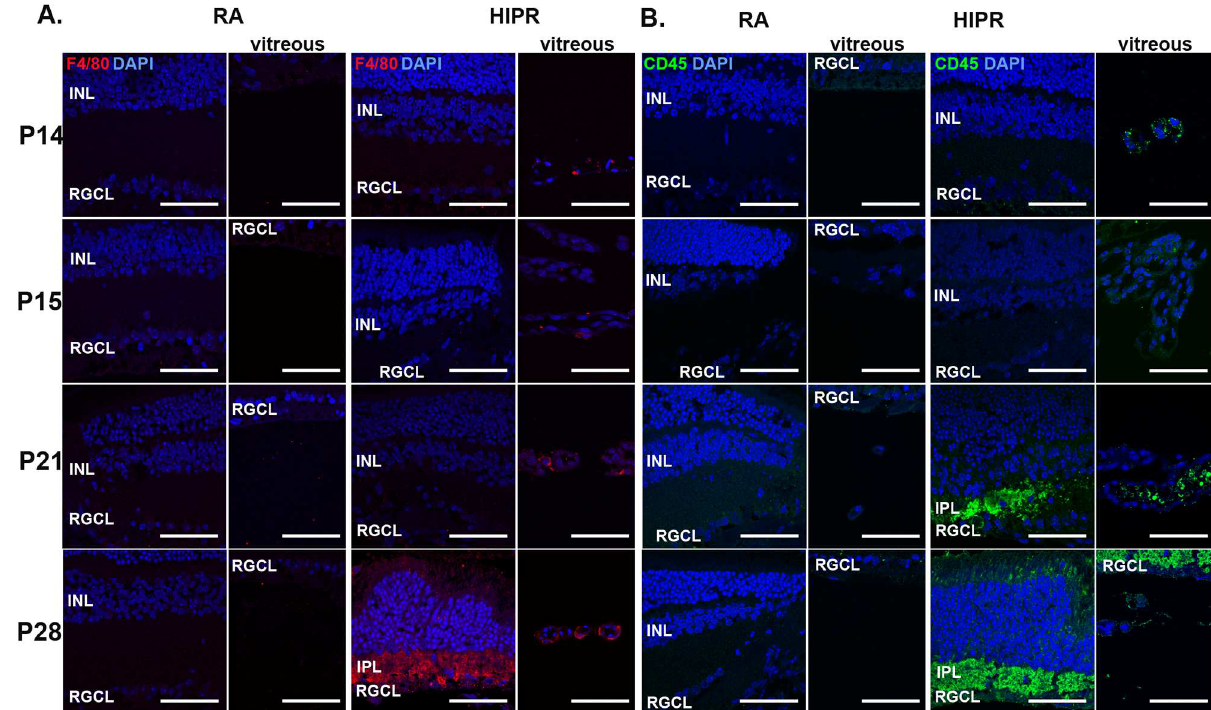
Fig 8. White blood cells present in the inner plexiform layer in hyperoxia-induced proliferative retinopathy. (A) Retinalcross sections were immunostained with (A) F4/80 (red) or (B) CD45 (green) and counterstained with DAPI (blue, N = 3). In RA, there was no F4/ 80 or CD45 staining. In HIPR, F4/80 and CD45 were both seen in the IPL at P21 and P28. Scale bar, 50 μ m. INL, inner nuclearlayer. IPL, inner plexiform layer. RGCL, retinal ganglioncell